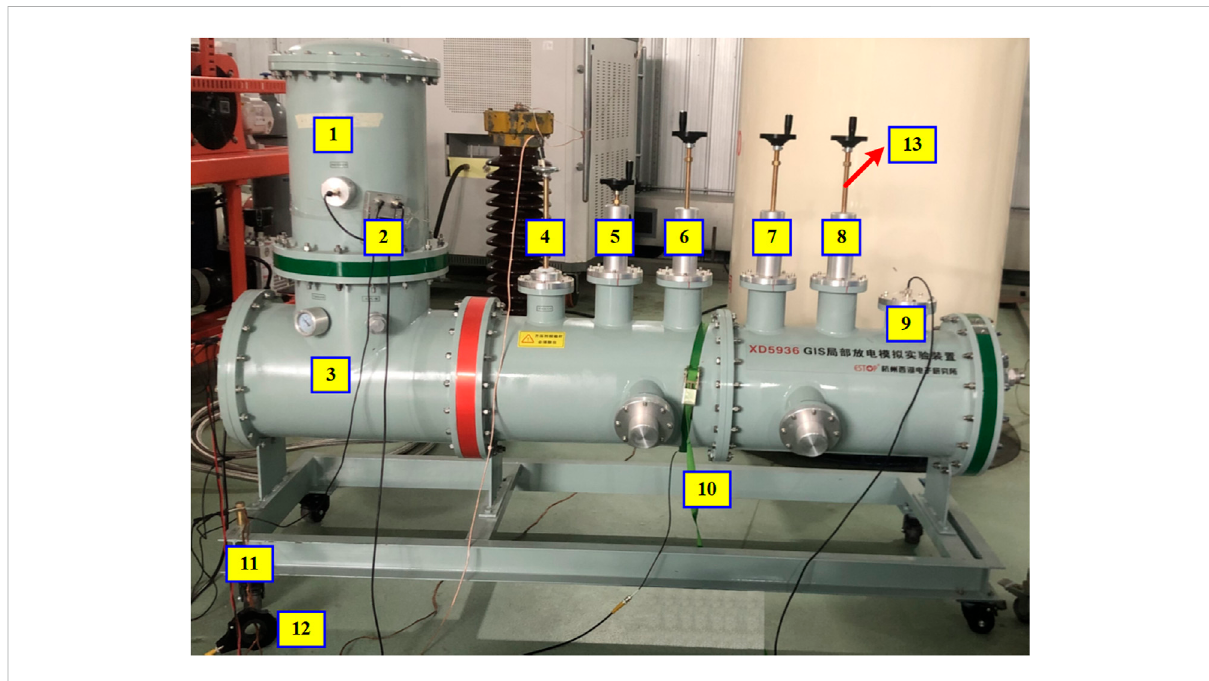
FIGURE 2 Structure of the partial discharge simulation